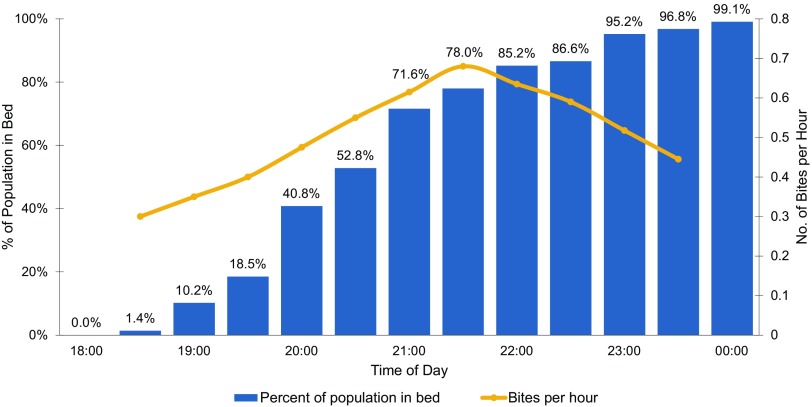
Percentage of the Population in Bed by Half-Hour (N=60 Observations) Compared With Anopheles darlingi Feeding Behavior,a Department of Loreto, Perua Data on mosquito feeding behavior come from Vittor (2003).41